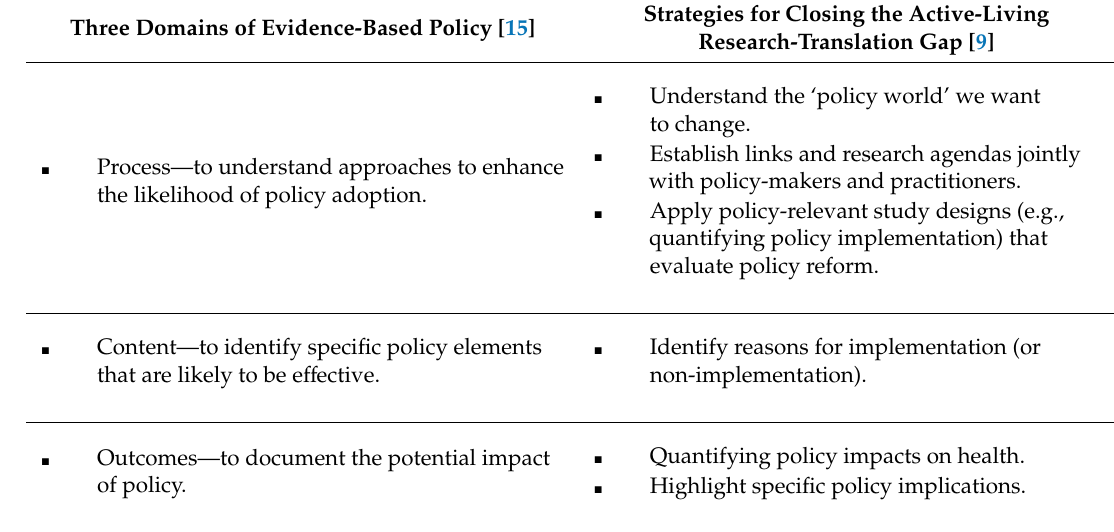
Table 1. Criteria for assessing the policy-relevant research-translation e ff orts of the RESIDE project. Three Domains of Evidence-Based Policy [15]